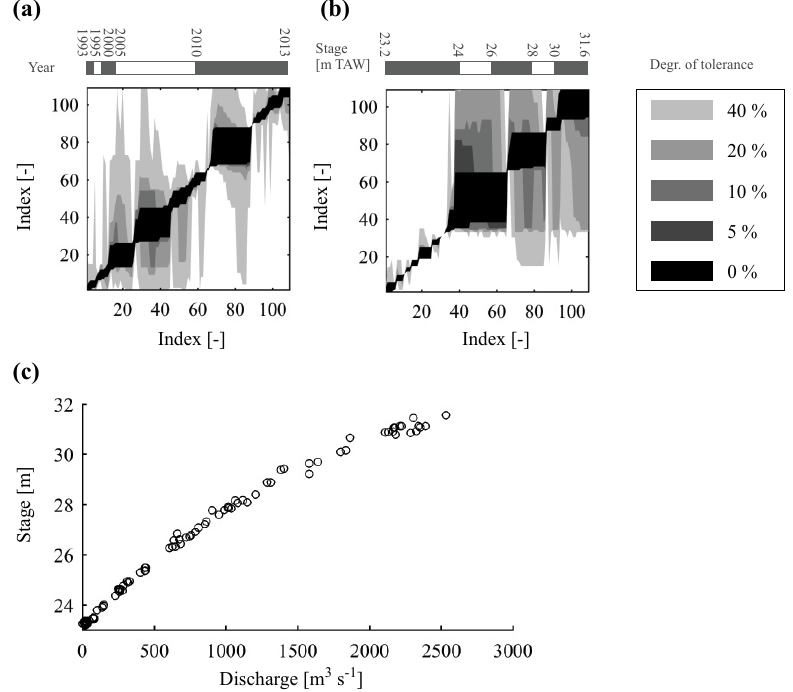
Figure 12. (a) Combined BReach t_2s plot (all data), (b) BReach h_1s plot (all data) for Maaseik. In all subplots, for each index on the x axis the gray area indicates the span between the index of the maximum left reach (under the bisector) and the maximum right reach (above the bisector). Each gray tint represents a different degree of tolerance (i.e., percentage of data points allowed to have nonacceptable model results). (c) Stage–discharge data for